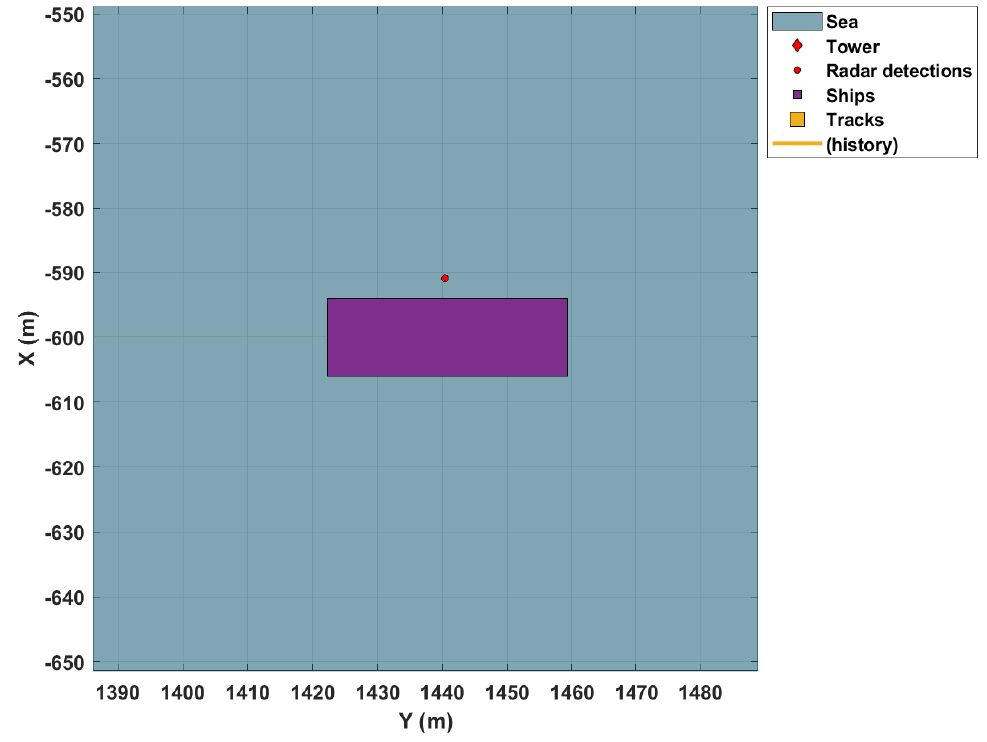
Figure 6. Target in